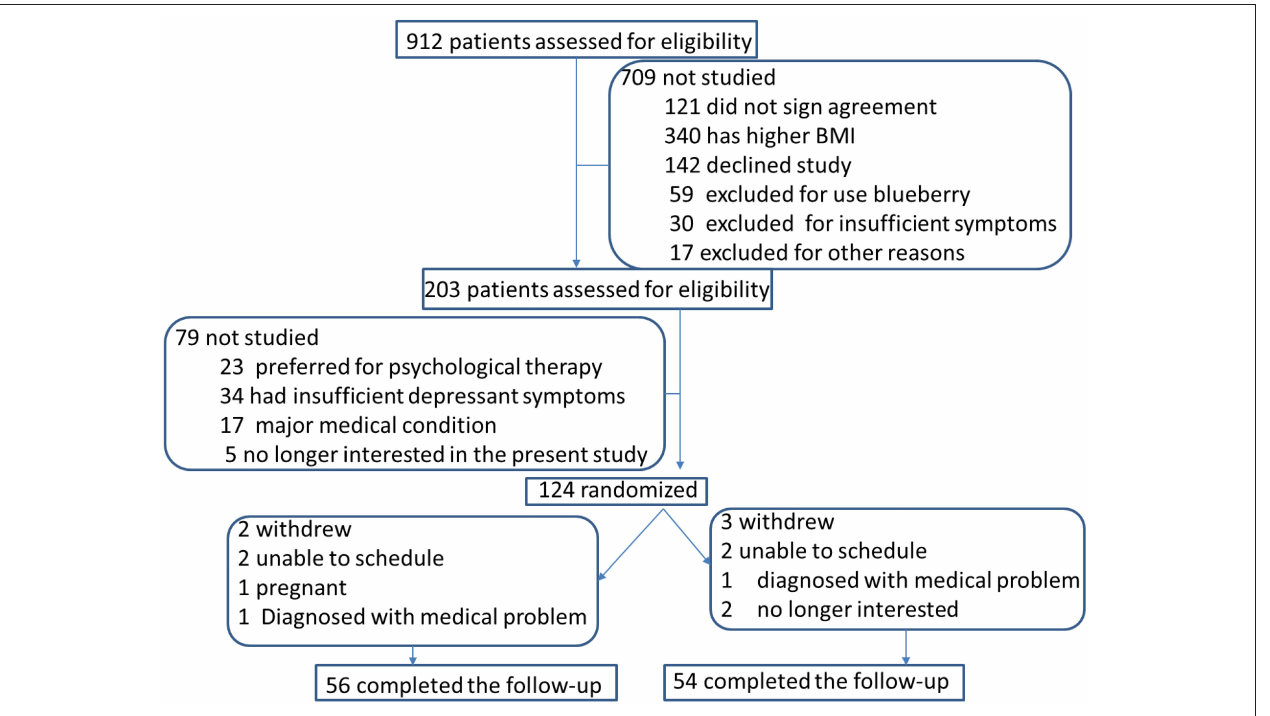
main factor. Correlation coefficients were calculated using Pearson product-moment correlation coefficient. All the data were expressed as mean ± standard deviation (S.D.) and analyzed using SPSS version 20.0 (SPSS Inc., Chicago, IL,